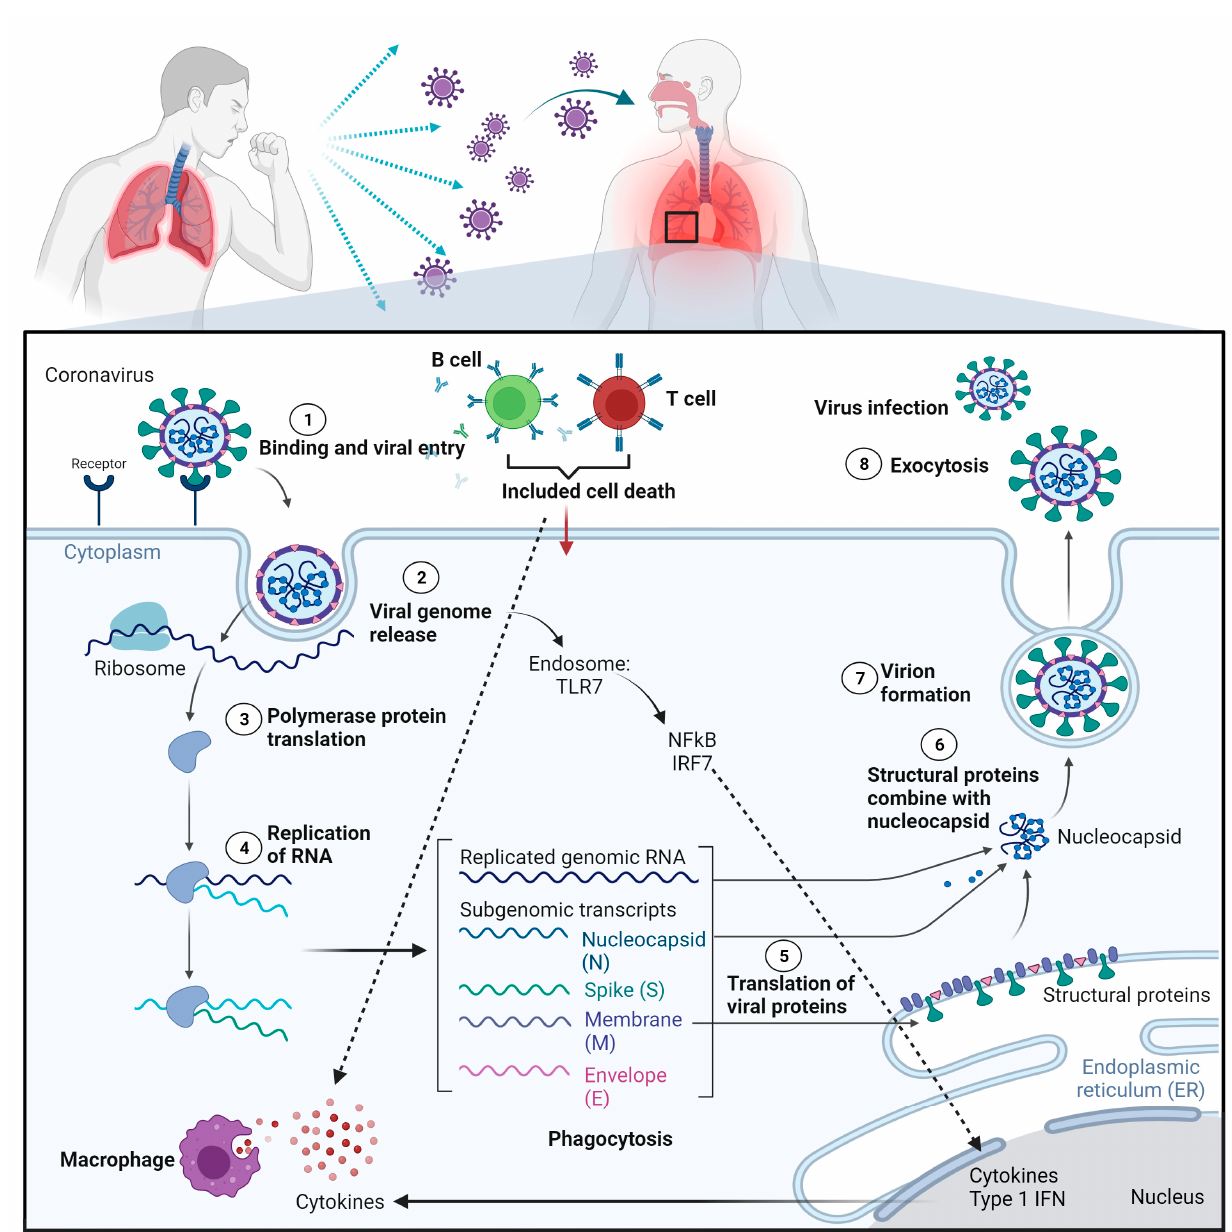
Figure 4. Schematic diagram representing SARS-CoV-2 pathogenesis. The surface S protein facilitates SARS-CoV-2 to enter host cells by attaching to ACE2 in synergy with the host’s TMPRSS2. In the host cells, cascade event of SARS-CoV-2 replication, leading to viral assembly, maturation, and virus release. On the other hand, SARS-CoV-2 RNA will be identified by TLR7 where multiple proteins are recruited to form a complex after viral RNA engages TLR7, which increases the transfer of transcription factors like NF-kB and IRF7 to the nucleus and triggers the release of proinflammatory cytokines that are responsible for the development of sign and symptoms of COVID-19.